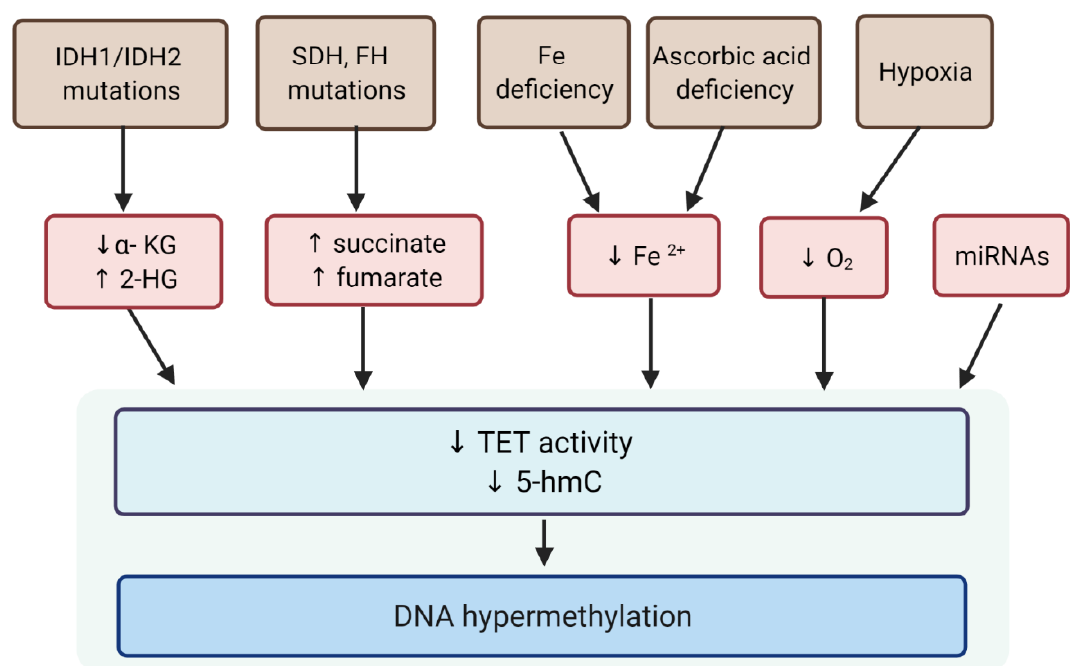
Figure 3. Factors involved in the regulation of TET activity. IDH1/IDH2: NADP-dependent isocitrate dehydrogenase; SDH: succinate dehydrogenases; FH: fumarate hydratase; α-KG: alpha-ketoglutarate; 2-HG: 2-hydroxyglutarate; TETs: Ten-eleven translocation enzymes; 5-hmC: 5-hydroxymethylcytosine.